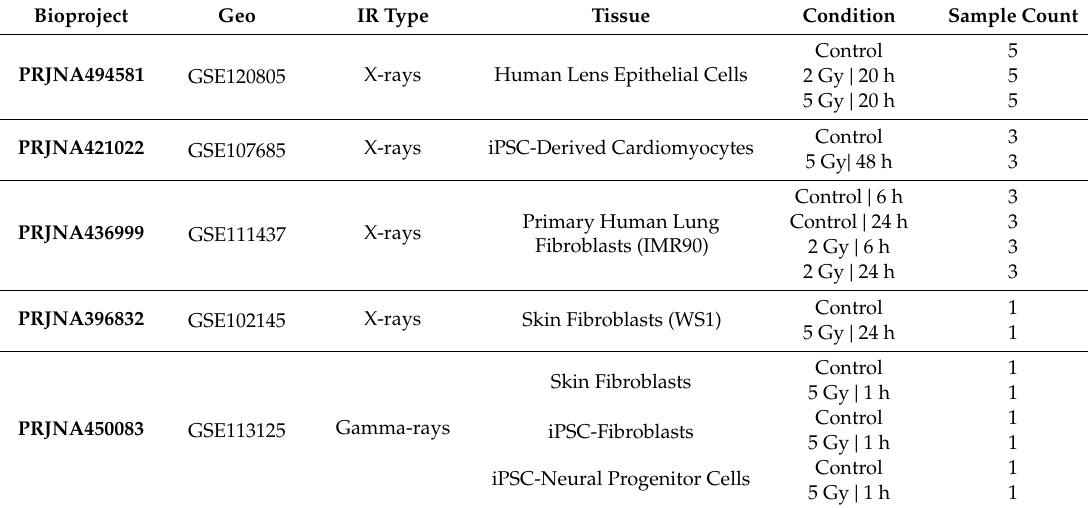
Table 1. Information of experiment accessions and sample